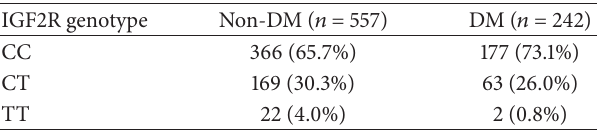
Table 2: Genotype distribution of rs416572 in relation to the presence of diabetes.